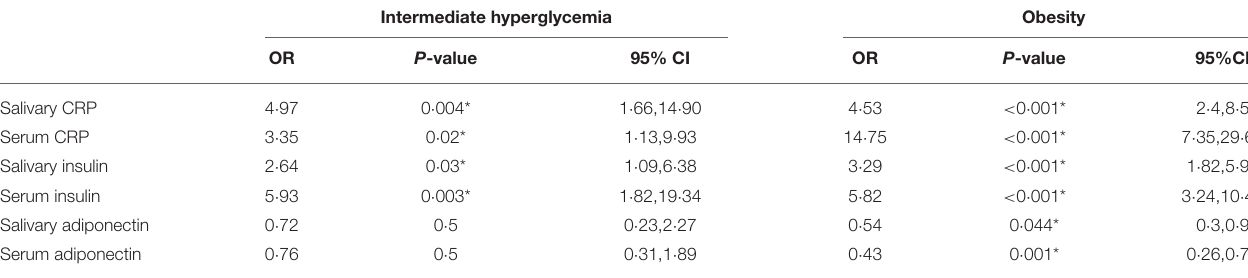
TABLE 5 | Multiple logistic regression models for the associations of C-Reactive Protein, insulin, and adiponectin with intermediate hyperglycemia and obesity using data from visit 3. Intermediate hyperglycemia